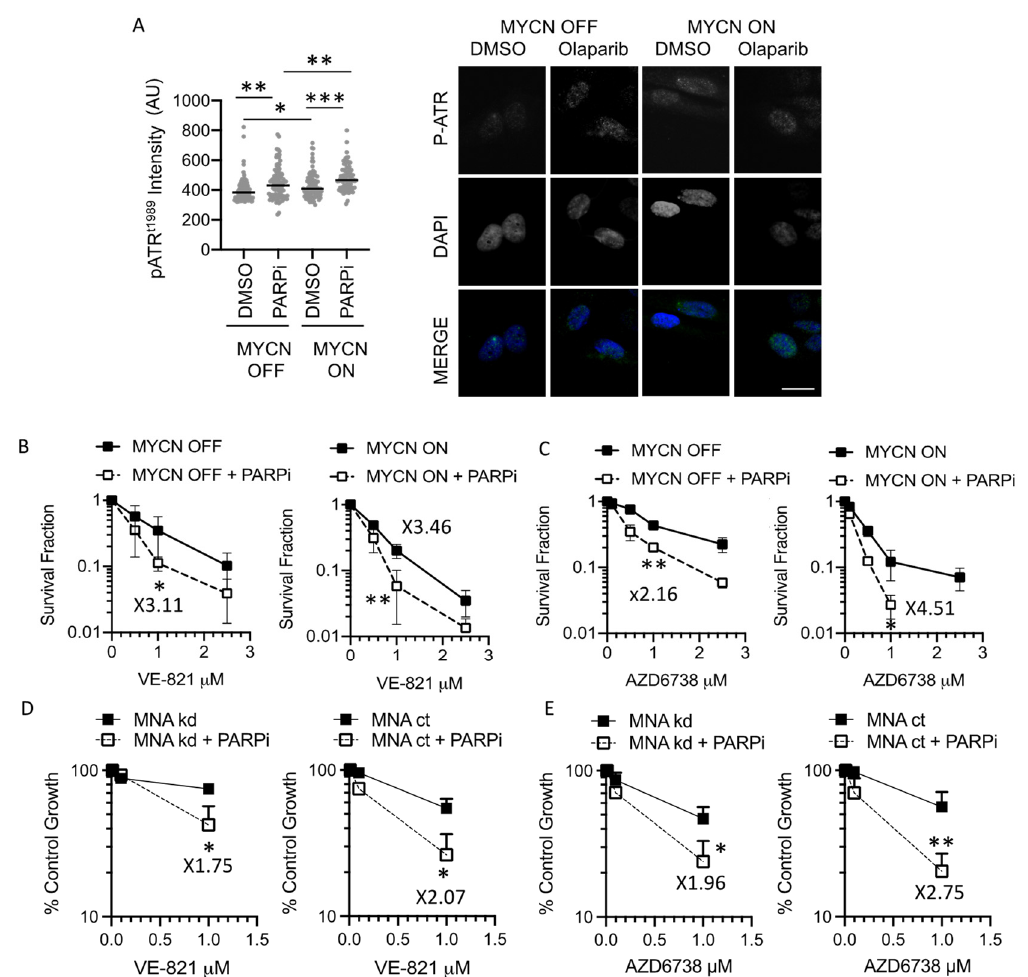
Figure 3. PARP inhibition activates ATR and sensitises NB cells to ATR inhibitors independent of MYCN expression. ( A ) example images and mean cell intensity of phosph-ATR(Thr1989) in SHEP-Tet21/N cells with MYCN ON or MYCN OFF 24 h post treatment with 1 µM PARP inhibitor Olaparib or DMSO control. n > 80 cells. Scale bar = 10 μ m. ( B ) Survival fraction of SHEP-Tet21/N NB cell line with MYCN ON or OFF as measured by clonogenic survival assay 14 days post treatment with ATR inhibitors VE-821 and ( C ) AZD6783 with or without 0.5 µ M Olaparib. ( D ) Growth inhibition (% control growth) of the IMR5/75 sh MYCN cell line in MYCN ON and knock down (KD) states measured by XTT cell proliferation assay post treatment with ATR inhibitors VE-821 and ( E ) AZD6783 with or without 1 µ M Olaparib for 72 h. Statistical significance and sensitisation factor was calculated using the Student’s t -test, comparing MYCN OFF and MYCN ON cells at 1 µ M. Mean and standard deviation of 3 independent repeats are shown. *, ** and *** = p < 0.05, 0.01 and 0.001 respectively. Sensitisation factor was calculated in each case as the fold change in survival or growth between with and without PARPi at 1 µM ATRi.